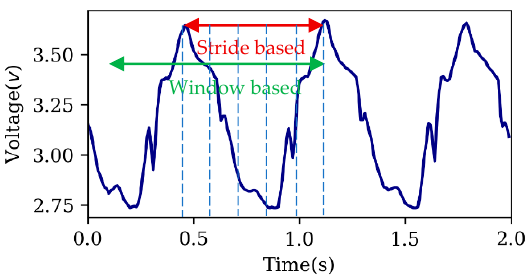
Figure 3. The window-based and stride-based approached for sensor data segmentation.